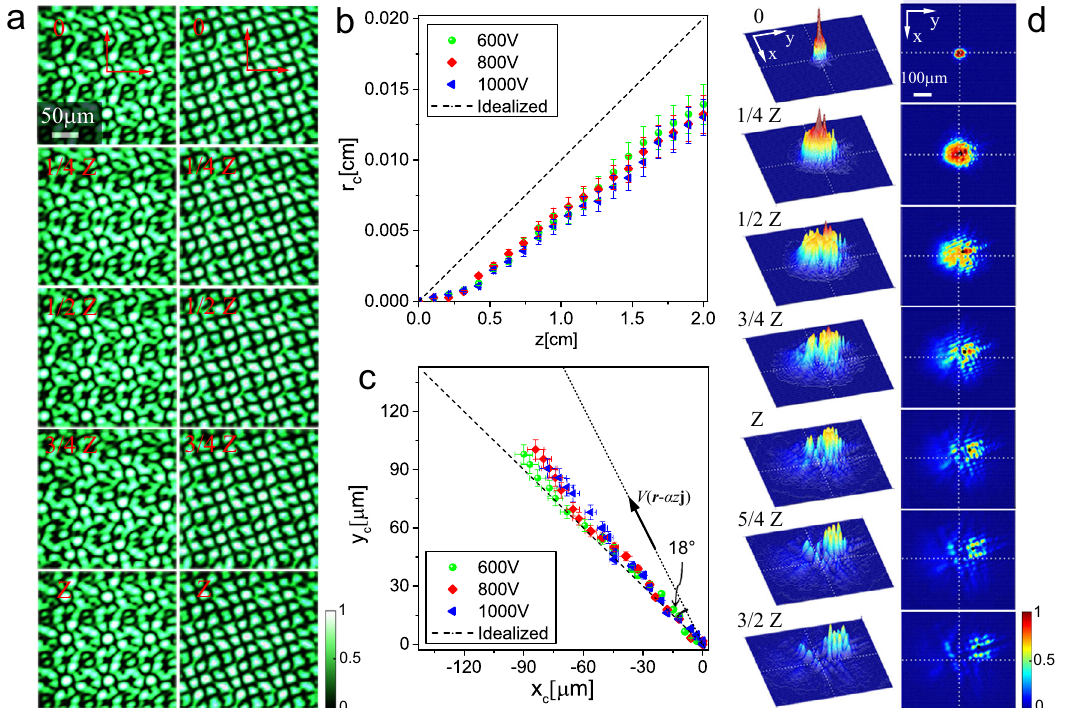
Fig. 3 | Experimental observation of two-dimensional Thouless pumping. a Optically induced moiré lattices with I 2 / I 1 =1.0 (left column) and I 2 / I 1 =0.1 (right column) at different propagation distances inside the sample. Panels b – d correspond to the right column. b Measured COM displacement ∣ r c ∣ with z . c The measured trajectory r c =( x c , y c ) in the transverse plane for various voltages